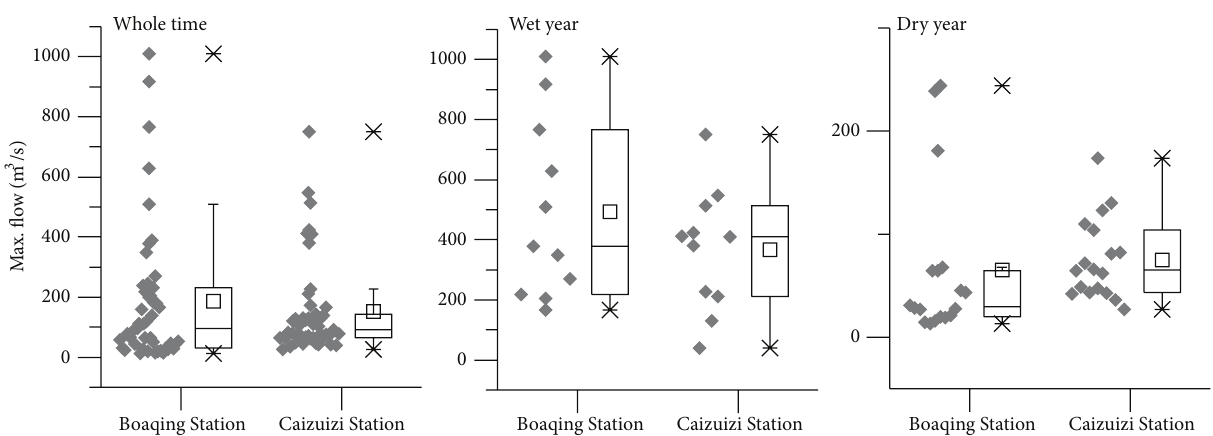
Figure 3: Maximum peak flow of Baoqing Station and Caizuizi Station from June to November between 1959 and 2005.